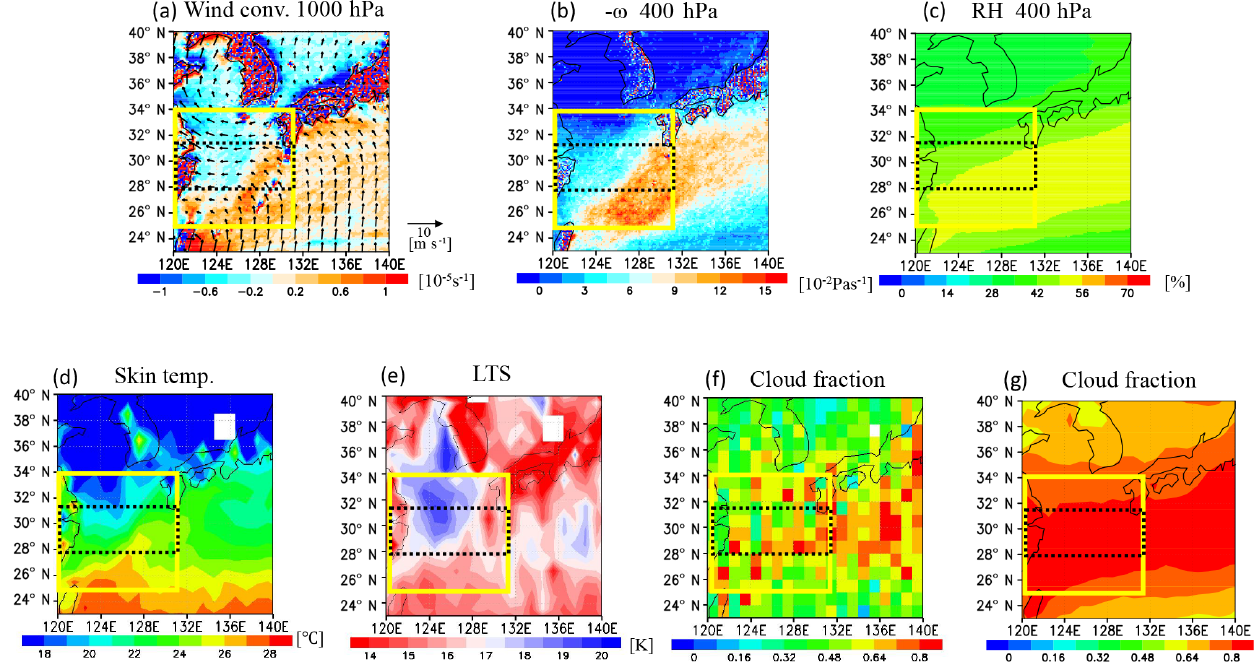
Figure 1. (a) Mean wind convergence (divergence) at 1000hPa (color; 10 − 5 s − 1 ) and wind vector (vector; ms − 1 ); (b) upward pressure velocity at 400hPa: − ω (10 − 2 Pas − 1 ); (c) relative humidity at 400hPa (%) for the target period from the Japan Meteorological Agency’s mesoscale model (MSM). (d) Mean skin temperature ( ◦ C), (e) lower-tropospheric stability (K), and (f) cloud fraction for the target period using CloudSat products. (g) Cloud fraction for the target period using Aqua/MODIS